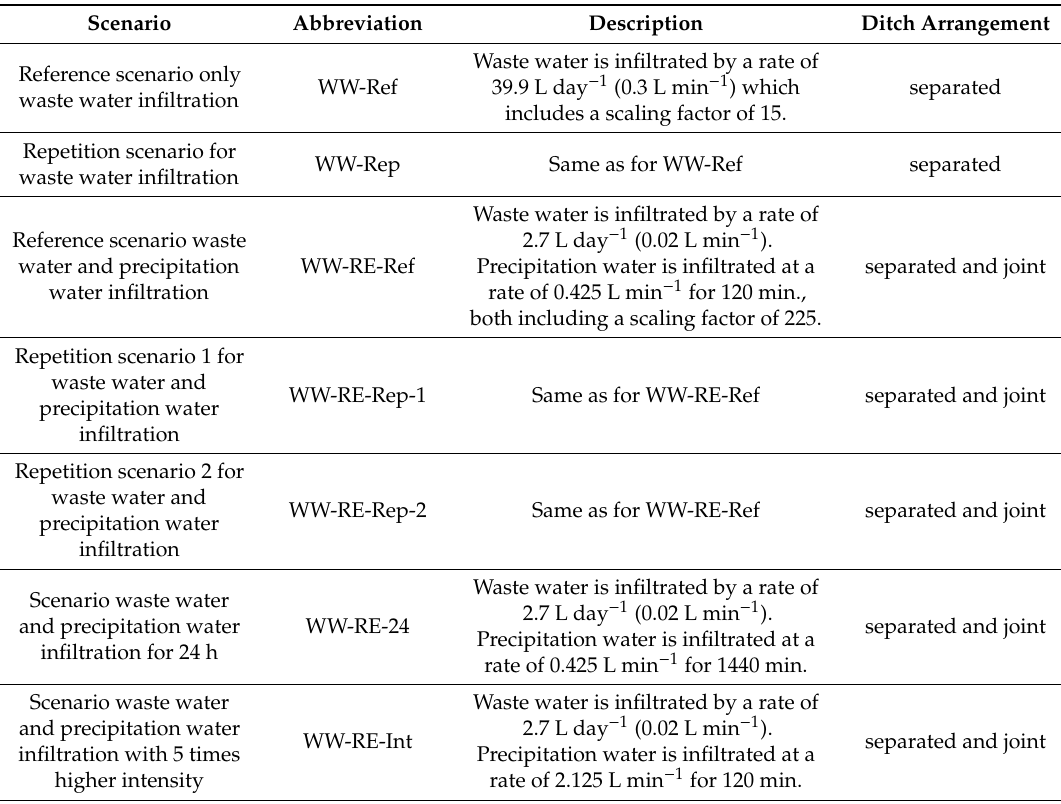
Table 5. Scenarios analyzed in the tank experiment (WW denotes a scenario applying only the waste water infiltration ditch, WW-RE denotes a scenario applying both the waste water and the precipitation water infiltration ditch), scaling factors refer to a real-world